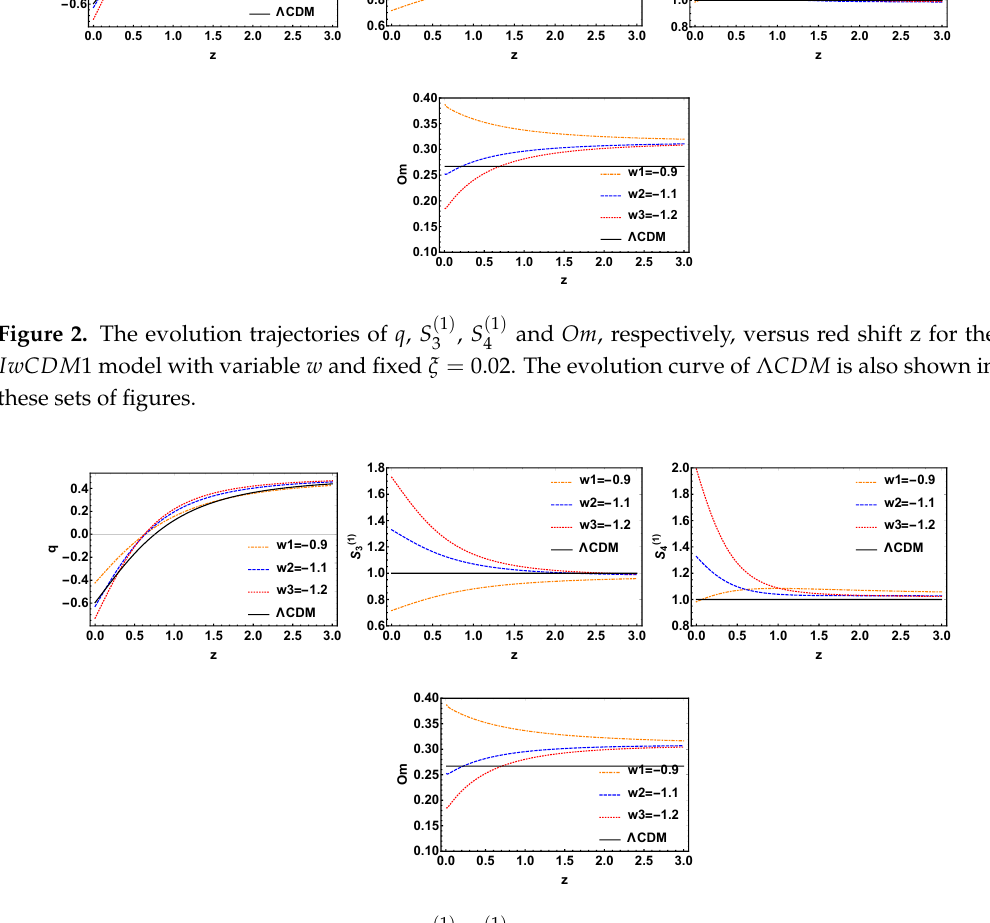
Figure 3. The evolution trajectories of q , S IwCDM 2 model with variable w and fixed ξ = 0.02. The evolution curve of Λ CDM is also shown in these sets of